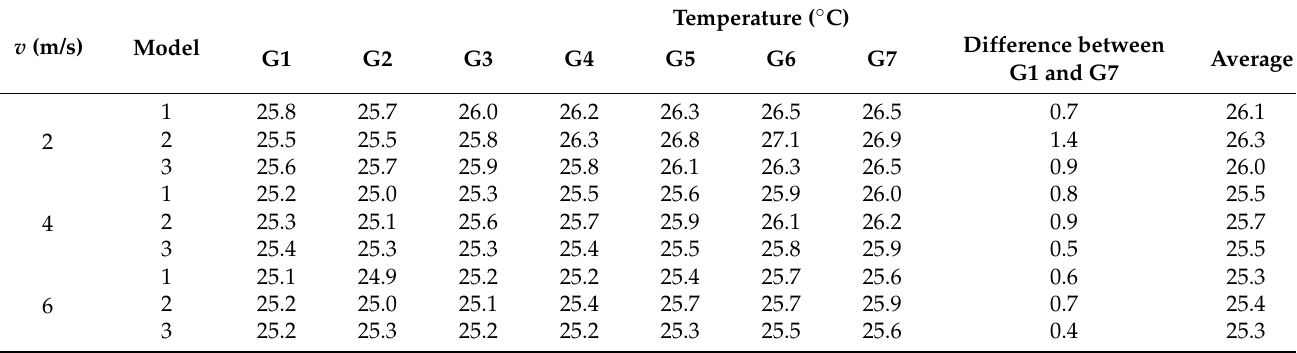
Figure 12. Velocity distribution of the three models’ yz plane of x = 2.6 m, at v = 6 m/s, ( a ) Model 1; ( b ) Model 2; ( c ) Model 3.